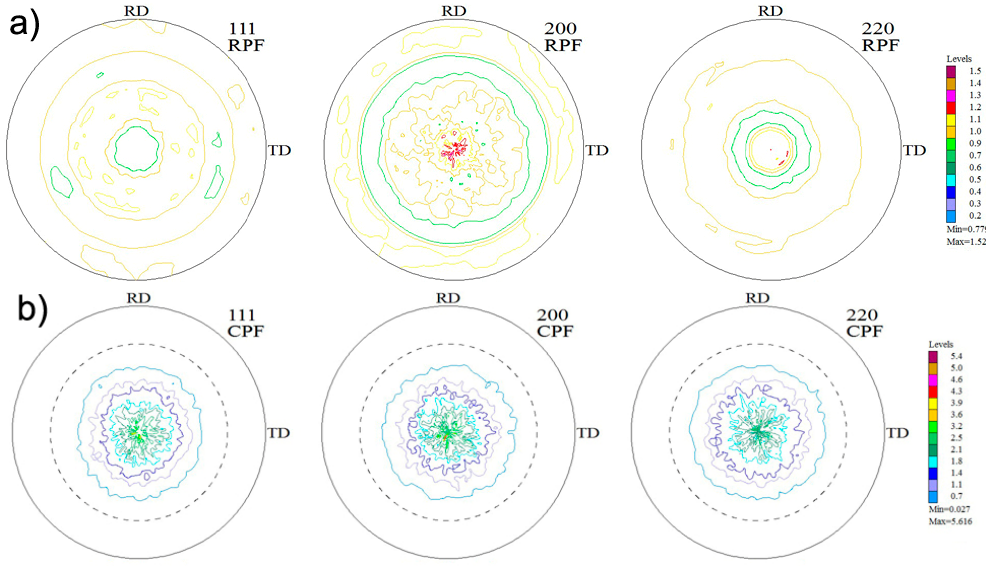
Figure 9. Pole figures: calculated ( a ) and experimental ( b )—(111), (200), (220) for AA6061/10 vol % MLG composites obtain in SPT process.